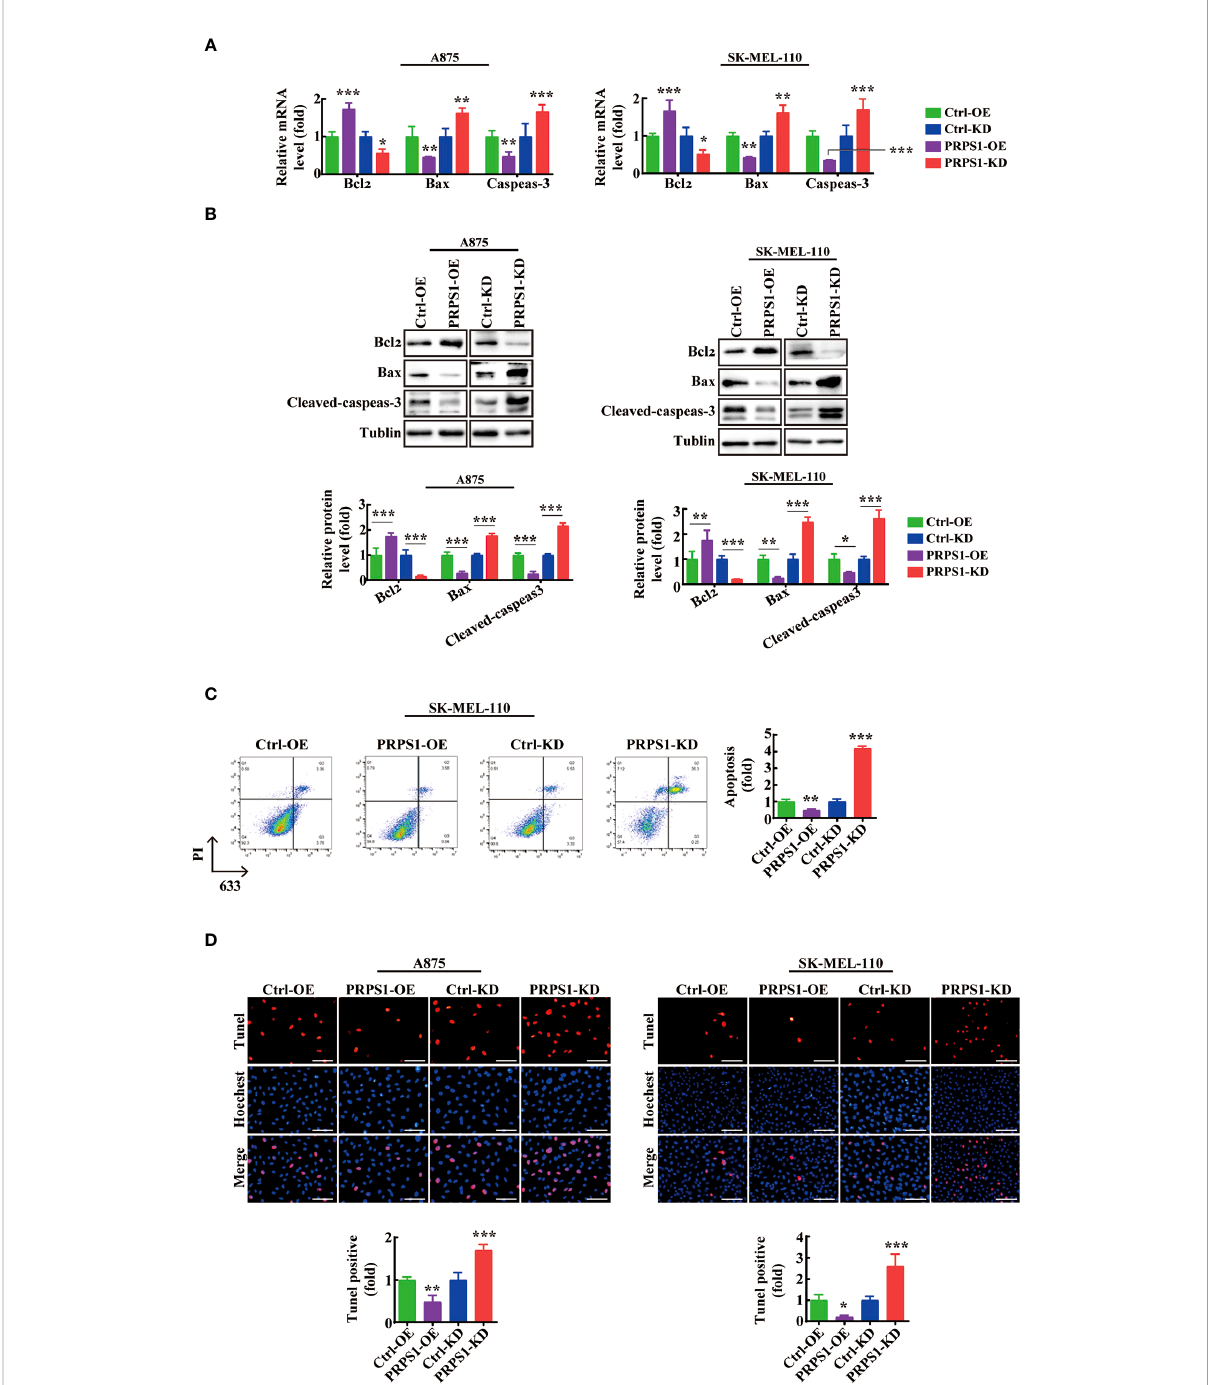
FIGURE 3 PRPS1 inhibits melanoma cell apoptosis. (A, B) The expressions of apoptosis related factors Bcl2 and Bax and Cleaved-caspeas-3 in A875 and SK-MEL-110 and the related control cells stably transfected with PRPS1 were detected by (A) qPCR and (B) western blotting analysis. (C) The anti-apoptotic ability of SK-MEL-110 cells overexpressing or knock-down PRPS1 and the control cells were evaluated by fl ow cytometry. (D) TUNEL analysis was used to analyze the anti-apoptotic ability of A875 (left) and SK-MEL-110 (right) over-expression or knock-down PRPS1 and the control cells. Scale bars=75 m m. The data represent three independent experiments. Each bar represents mean ± SD. p values were calculated using a student t-test (*p < 0.05, **p < 0.01, ***p < 0.001 vs. each